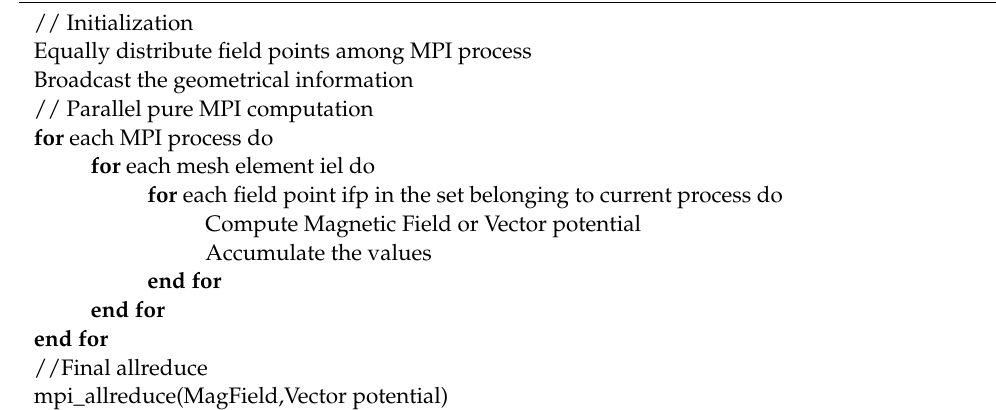
Algorithm 3 Evaluation of Q m, pure MPI